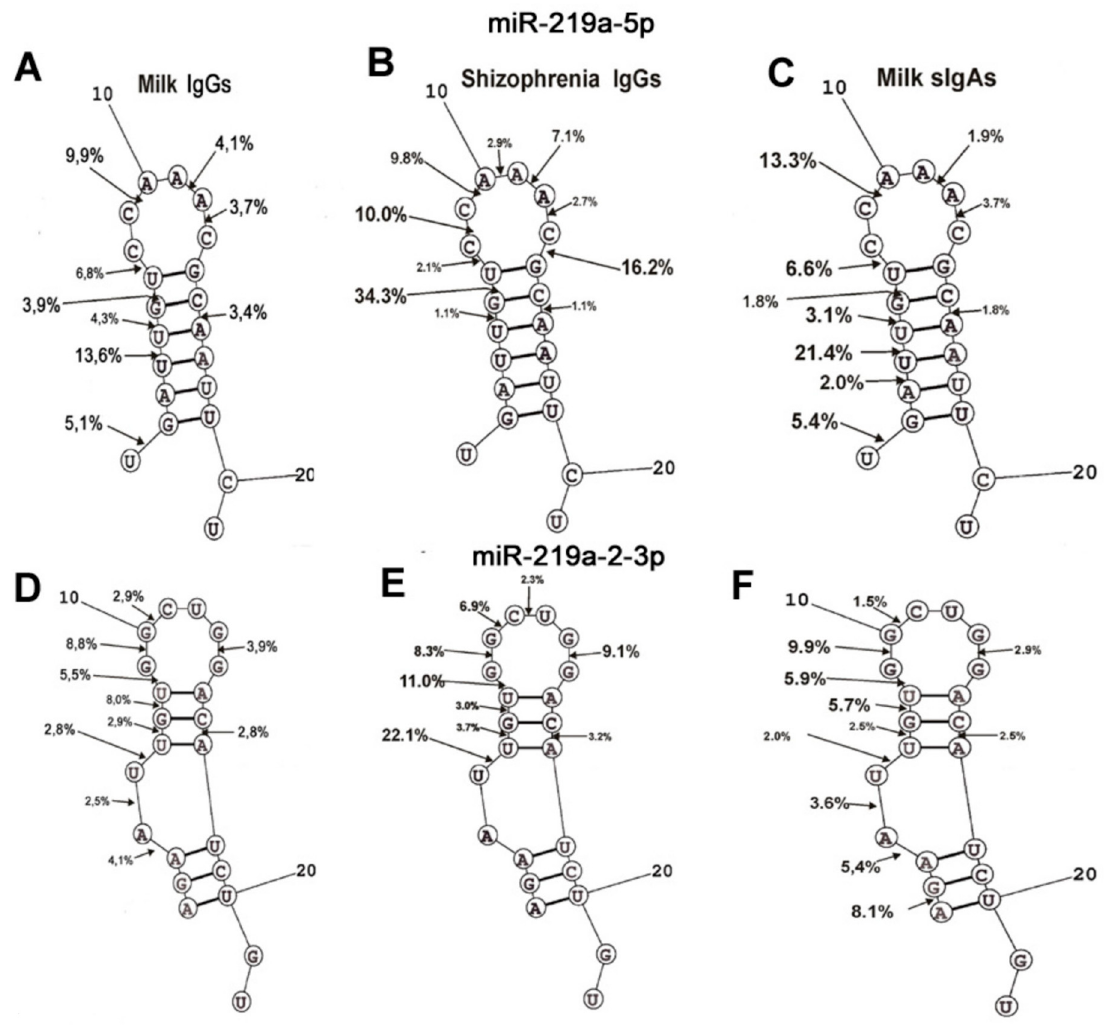
Figure 6. The average e ffi ciency of Flu-miR-219a-5p ( A–C ) and Flu-miR-219a-2-3p ( D–F ) by seven milk IgGs ( A , D ), IgGs of SCZ patients ( B , E ), and seven milk sIgAs ( C , F ) in all sites of their cleavage. The average percentage of two miRNA cleavages at di ff erent sites and positions of major and moderate sites of miRNAs hydrolysis by all Abs are shown on the panels. For comparison, the data on the hydrolysis of miRNAs by milk sIgA [62] and the IgGs of schizophrenia patients [63,64] are taken from previously published